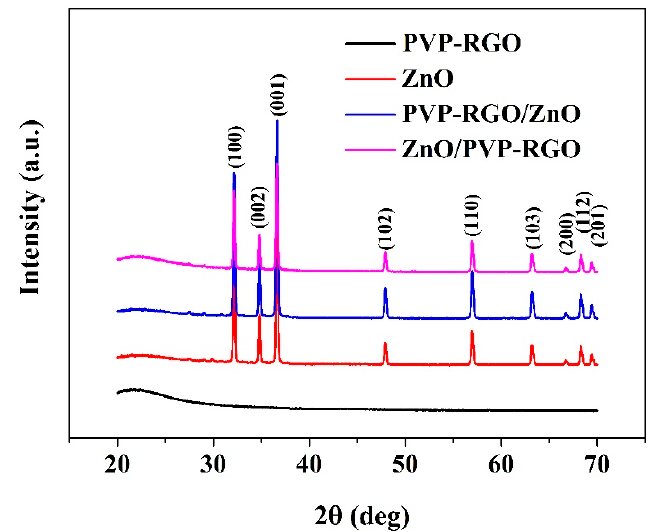
Figure 2. Typical XRD images of polyvinyl pyrrolidone–reduced graphene oxide (PVP-RGO), zinc oxide (ZnO), PVP-RGO/ZnO and ZnO/PVP-RGO films.